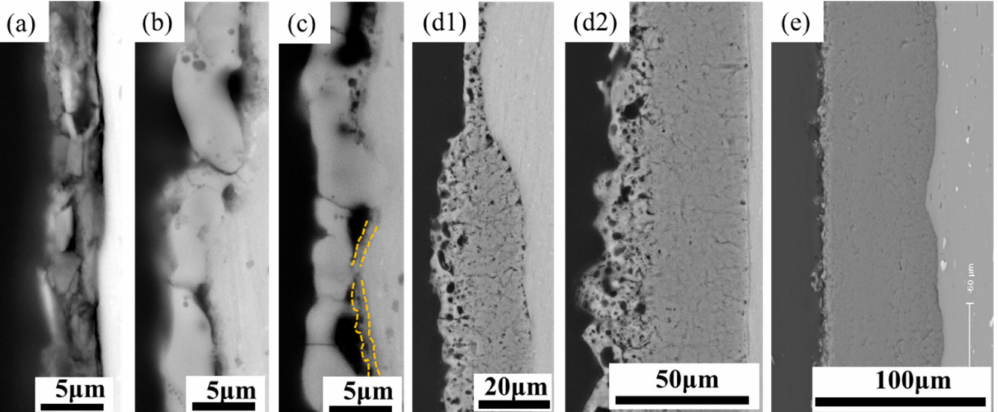
Figure 5. Cross-sectional micrographs of PEO coatings at different stages: ( a ) stage I; ( b ) stage II;